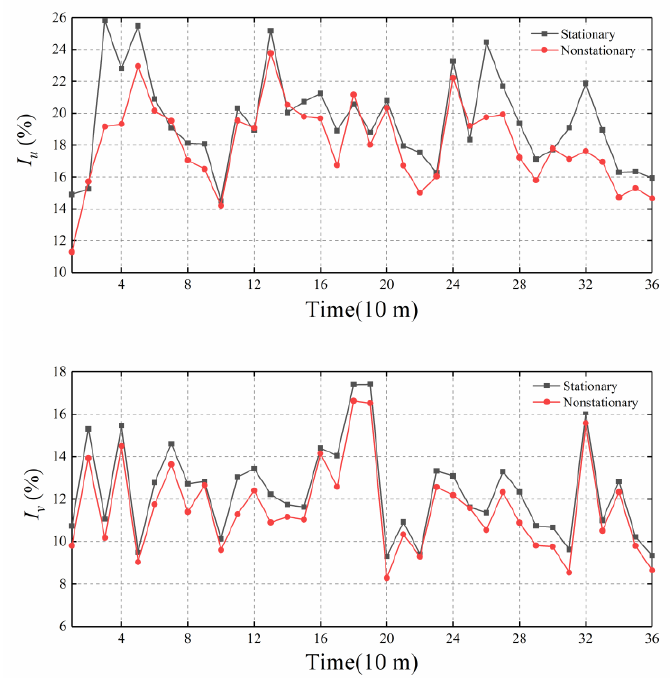
Figure 7. Comparison of the turbulence intensities of Typhoon Lekima with a 10-min duration.